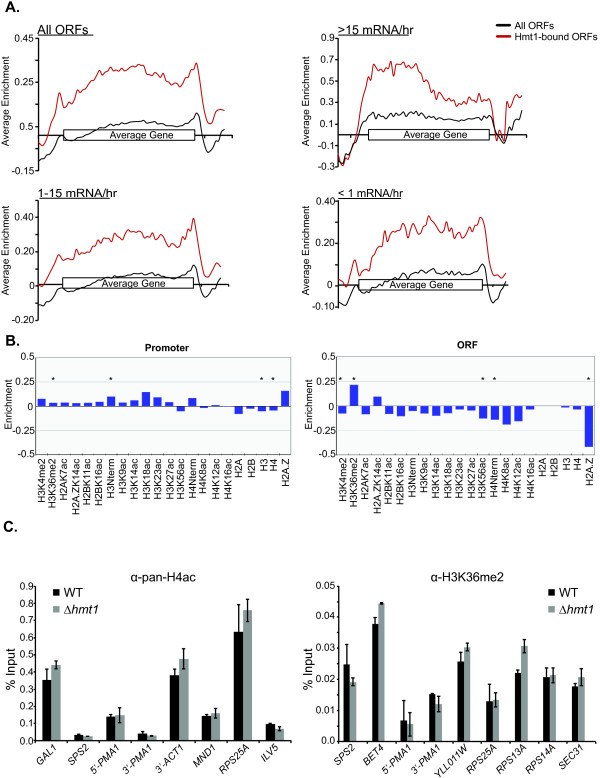
Hmt1-binding sites are enriched at ORF genes. A) Average Hmt1 enrichment profiles for all ORFs bound (“ALL ORFs), ORFs with high- (“≥ 15 mRNA/hr”), medium- (“1-15 mRNA/hr”), and low- (“ ≤ 1 mRNA/hr”) transcriptional frequencies. B) Histone enrichment/depletion calculations of promoters and genes for Hmt1-bound ORFs from ChromatinDB. C) Directed ChIP to assess the role of Hmt1 on the levels of pan-H4ac and H3K36me2. Representative ORFs bound-by Hmt1 were assayed for the level of the specified histone modification in WT and hmt1-null cells.